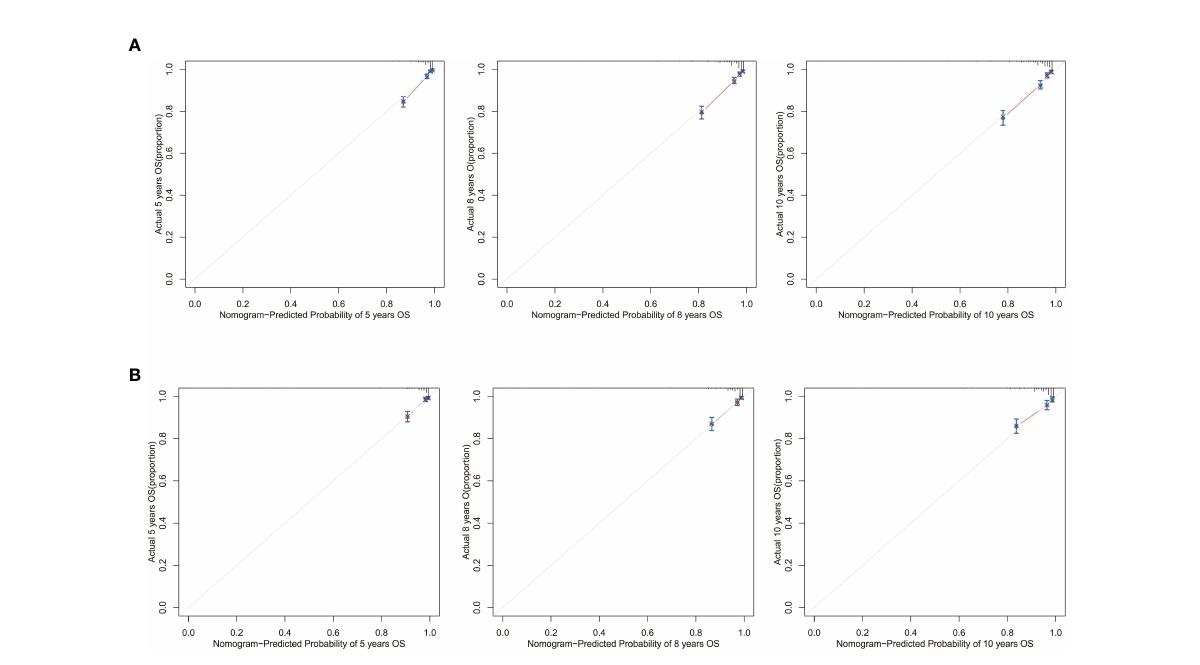
FIGURE 9 Calibration curves for the CSS nomogram. 5-, 8-, and 10-year calibration curves for the CSS nomogram in the (A) training cohort and (B) validation